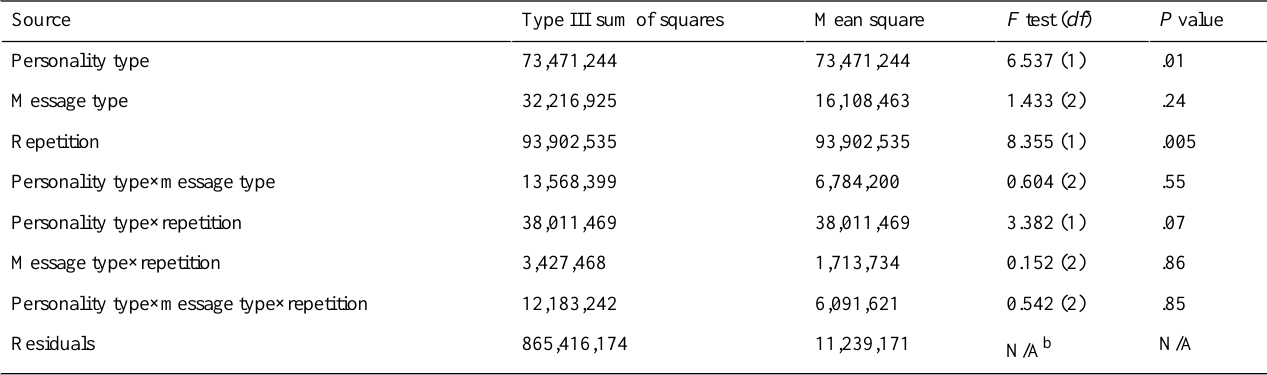
Table 2. Model testing results.